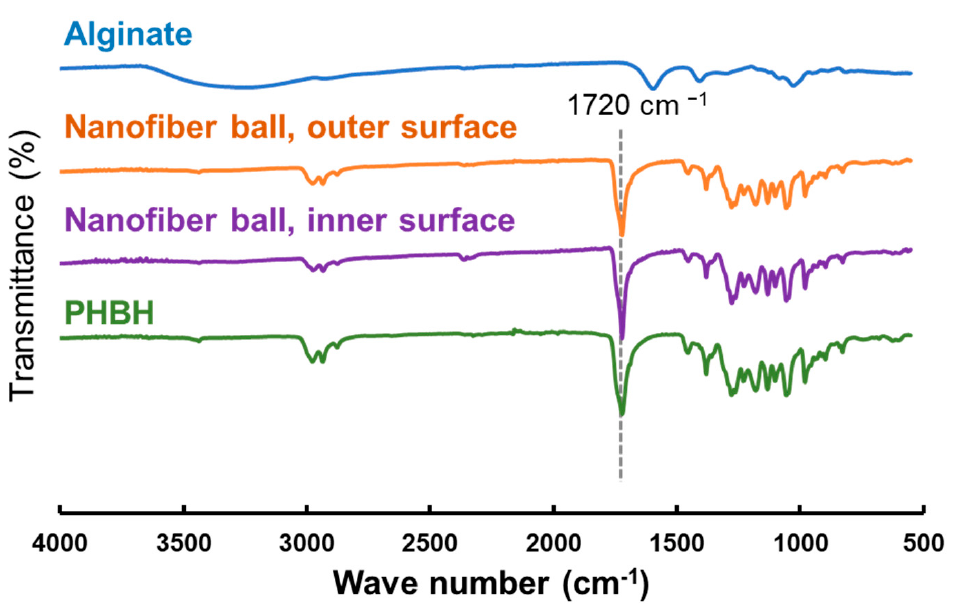
Figure 3. ATR-FTIR spectra of the alginate, inner, and outer surface of nanofiber-mâché ball, and PHBH.